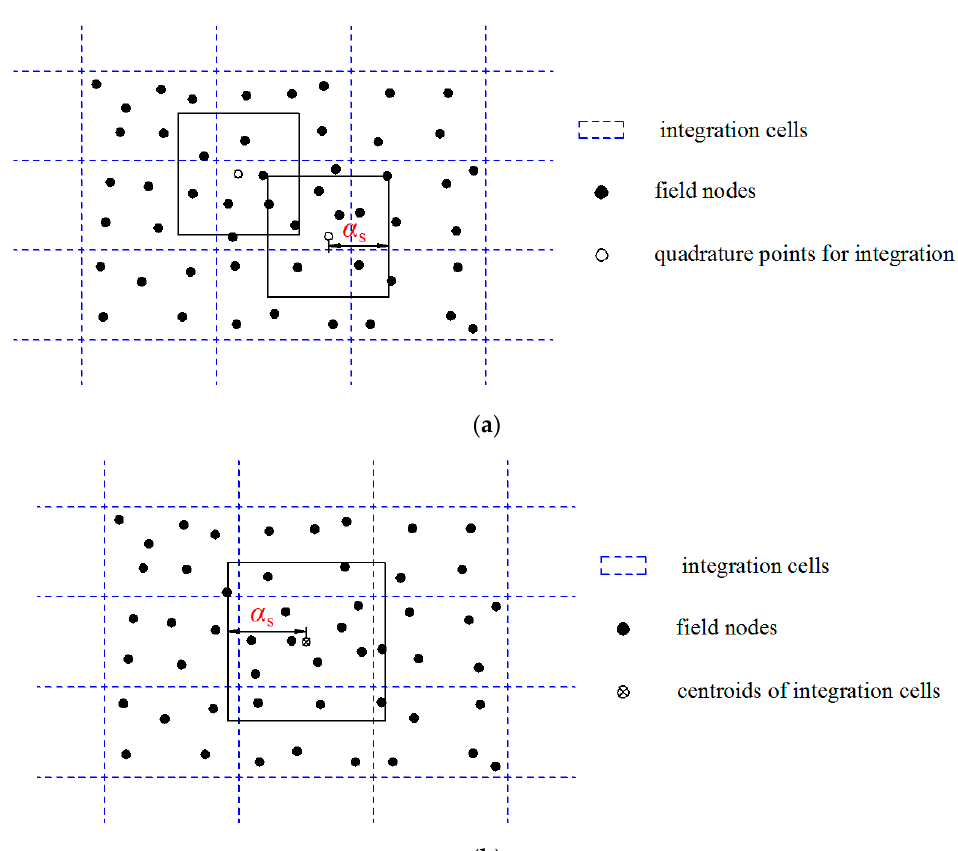
Figure 1. Comparison of the original RPIM and the present M-RPIM for node selection in the numerical approximation. ( a ) The node selection scheme in the original RPIM. ( b ) The node selection scheme in the present M-RPIM.